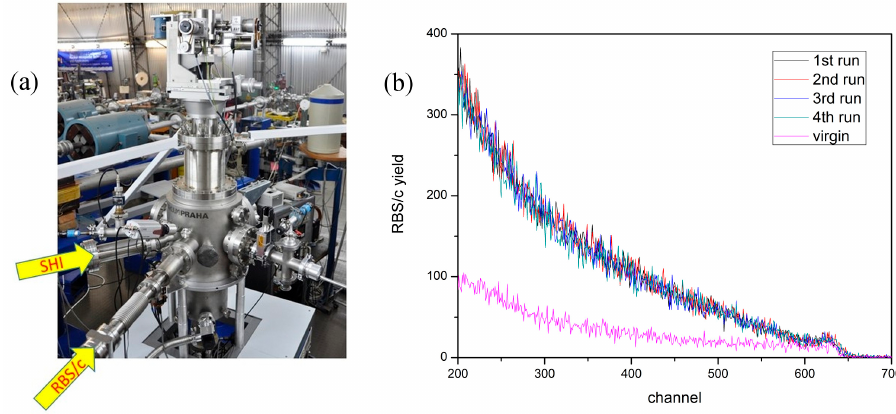
Figure 1. ( a ) Dual beam vacuum chamber for simultaneous swift heavy ions (SHI) irradiation and in situ Rutherford backscattering spectrometry in channeling mode (RBS/c) measurements; ( b ) Four successive RBS/c spectra obtained from an irradiated CaF 2 sample (23 MeV I, fluence 3 × 10 12 cm − 2 ). Spectrum from the virgin sample shown for comparison.